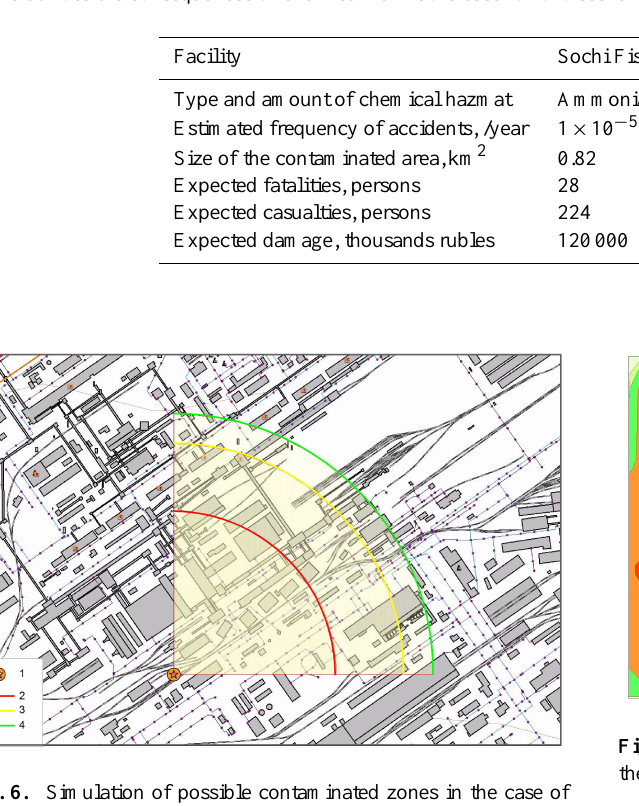
shown for different time intervals from 1 h up to 4 h. Ta-